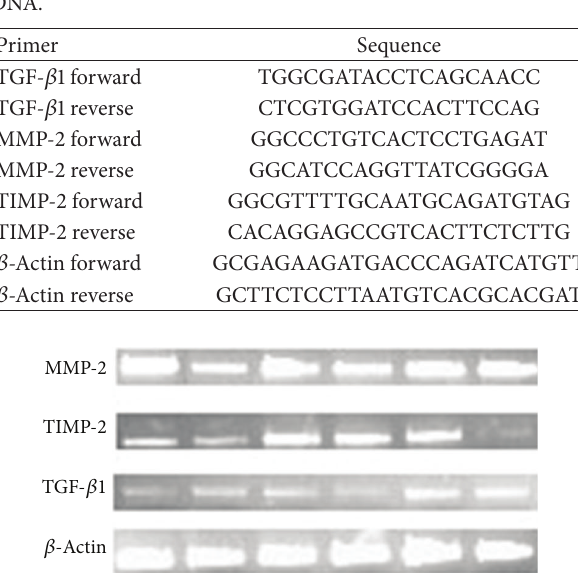
Figure 1: Electrophoretic bands of the q RT-PCR products before and within 15 days after the APG application. Note: the elec- trophoretic bands of the q RT-PCR products from left to right represent the expression of each target mRNA from the d0, d3, d6, d9, d12, and the d15 one by